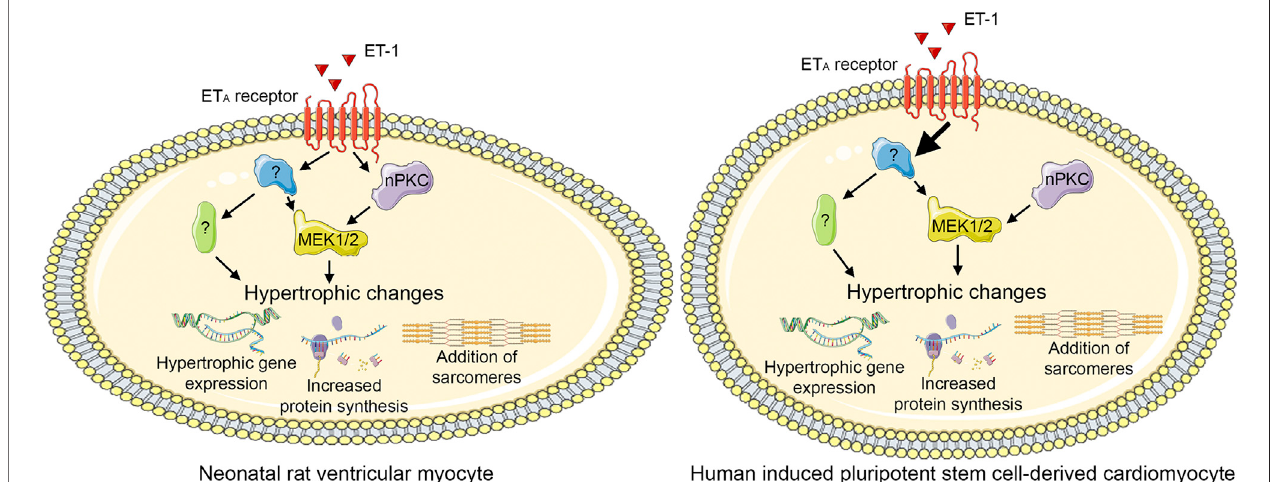
FIGURE 10 | Proposed PKC-mediated hypertrophic signaling. Endothelin-1 (ET-1) induces hypertrophy both via novel protein kinase C (nPKC) isoforms and mitogen-activated kinase kinase 1/2 (MEK1/2) and via other, PKC-and MEK1/2-independent, mechanism(s) in neonatal rat ventricular cardiomyocytes. In human induced pluripotent stem cell-derived cardiomyocytes, ET-1 induces hypertrophy independent of PKC, although also nPKC activation induces hypertrophy. This fi gure was created using images from Servier Medical Art (http://smart.servier.com). Servier Medical Art by Servier is licensed under a Creative Commons Attribution 3.0 Unported License